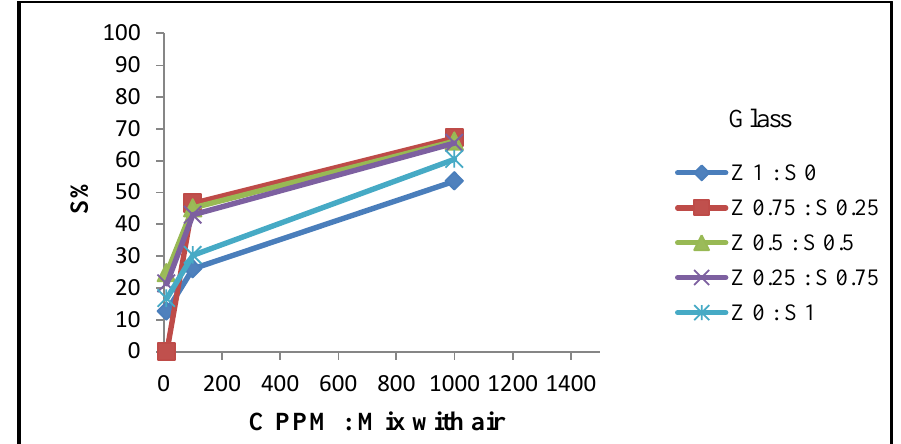
Fig. 17: Gas sensitivity of H